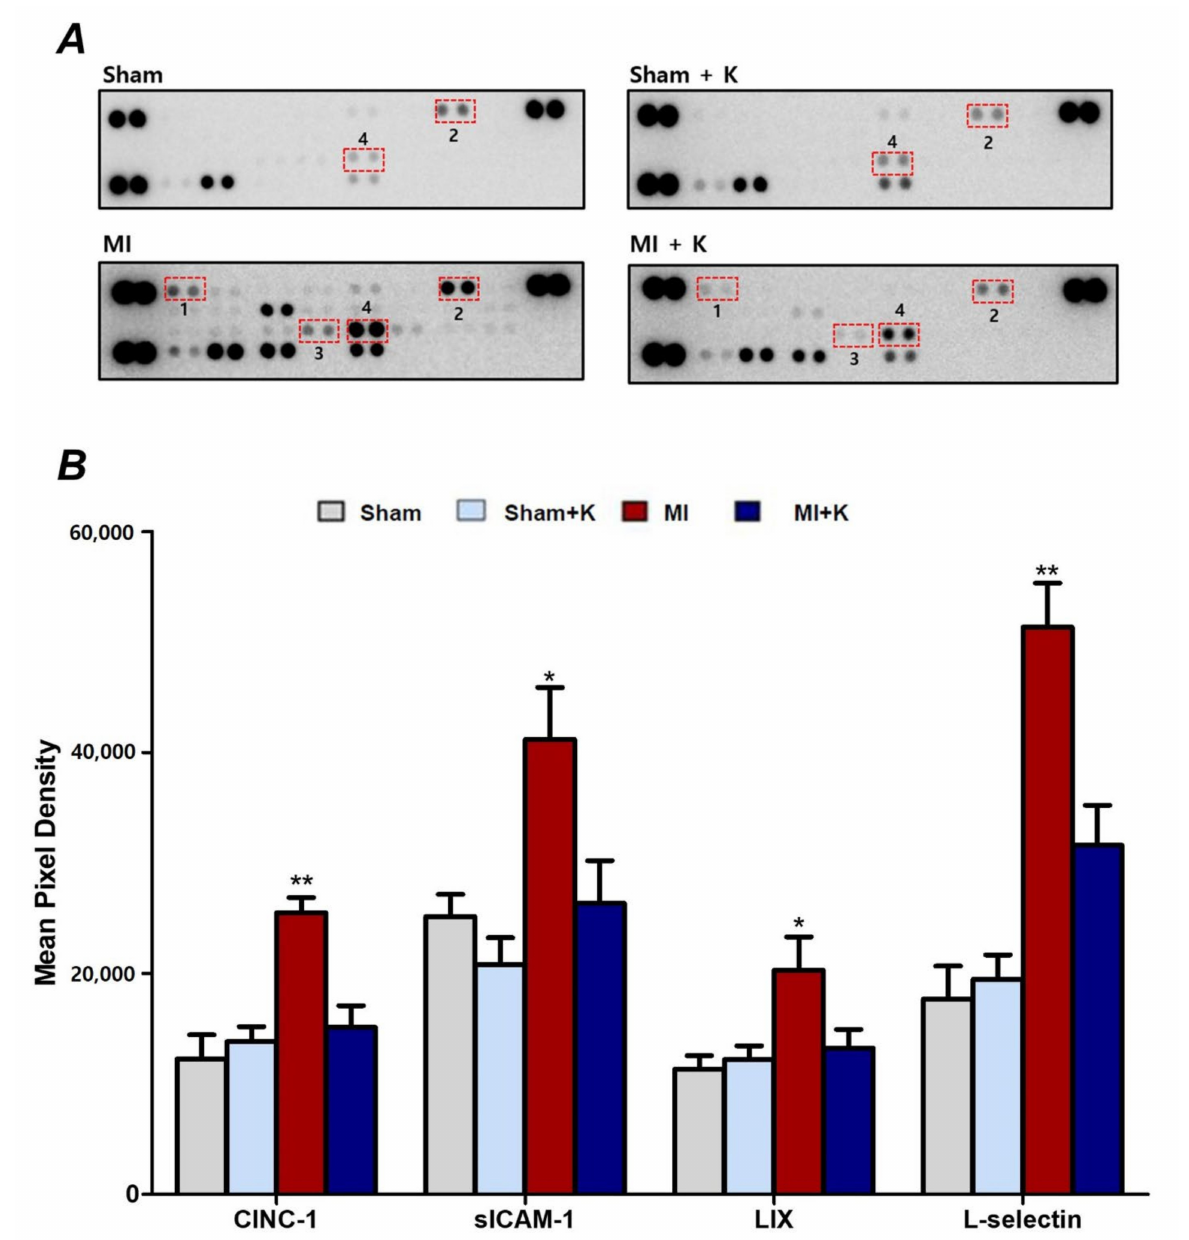
Figure 6. Expression levels of several cytokines. ( A ) Representative chemiluminescence images of the proteome profiler array after administration of klotho following myocardial I/R injury. The dotted line box indicates the selected candidate cytokines. ( B ) Expression levels of several cytokines, * p < 0.05, ** p < 0.01, comparison of myocardial ischemic/reperfusion (I/R) injury with and without recombinant klotho (rKL) administration by one-way analysis of variance (ANOVA) followed by Bonferroni post hoc test (the number of animals: n = 5,